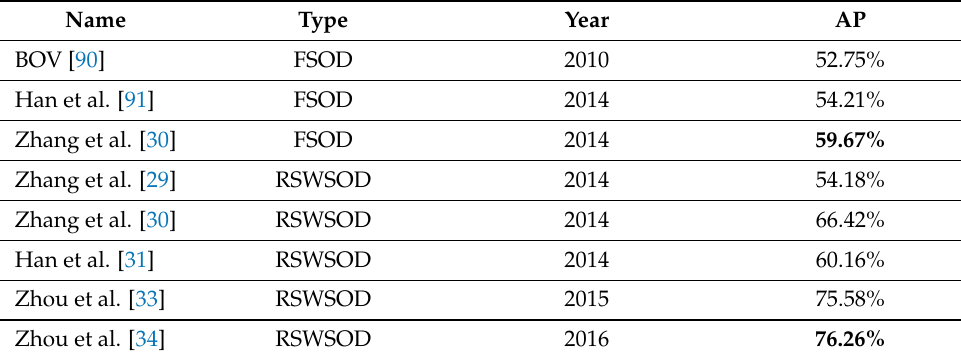
Table 4. Results of the methods on the Google Earth dataset. Furthermore, well-known methods from the literature are reported for a fair comparison. The best-performing techniques are indicated in